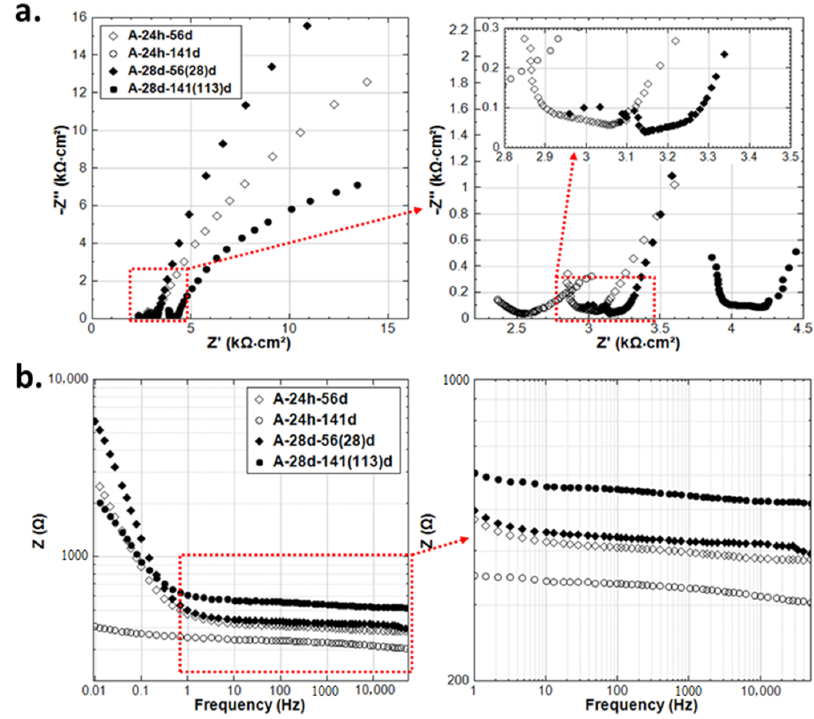
Figure 15. Overlay of EIS response of A-24h and A-28d in: ( a ) Nyquist format; ( b ) Bode format; at age of 56 and 141 days.